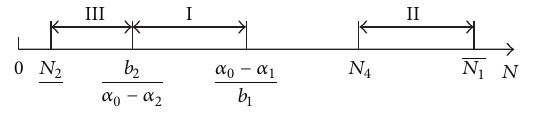
Figure 5: The optimal compensation mechanism in different inter-